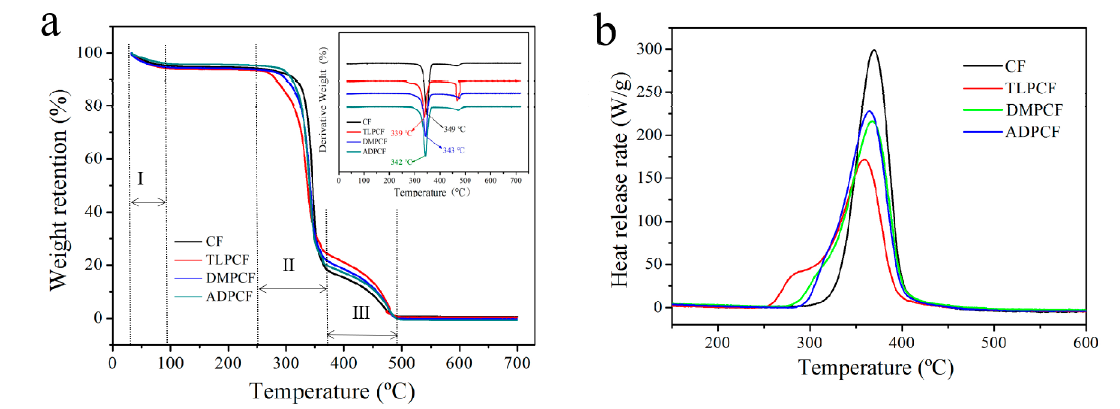
Figure 7. ( a ) TG, DTG, and ( b ) MCC of control and modified cotton fabrics.